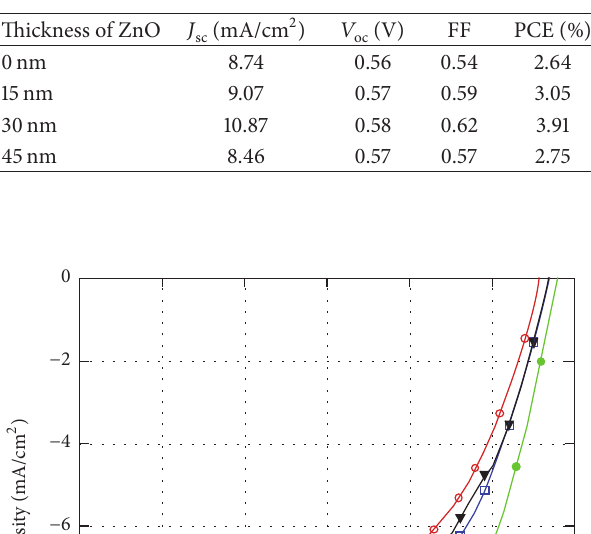
Table 4: Photovoltaic parameters of the devices with different thicknesses of ZnO, measured under 100mW/cm 2 illumination (AM 1.5G).